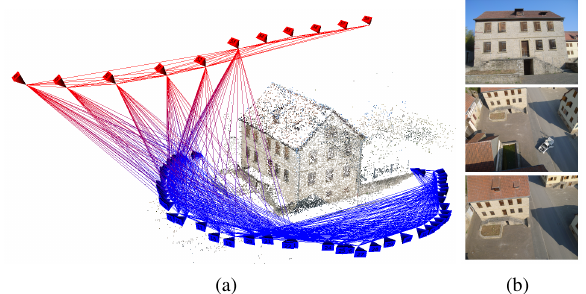
Figure 4. Image similarity matrices for the image set House con- structed using full pairwise matching of original (a) and embed- ded (b) SIFT descriptors. Each row/column correspond to an im- age, where darker cells represent higher